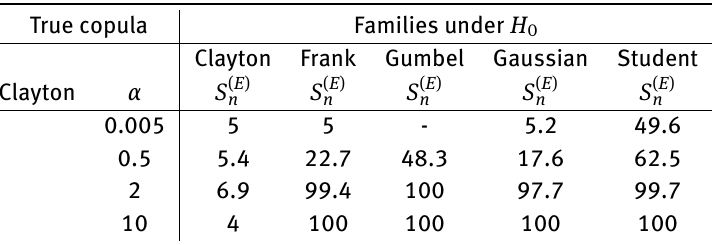
Table 5: Percentage of rejection at 5 % , based on 1000 replicates, of the null hypothesis of belonging to a given family of copu- las for N = 5000, n = m = 1000, r = 0.6 and p = 2 .